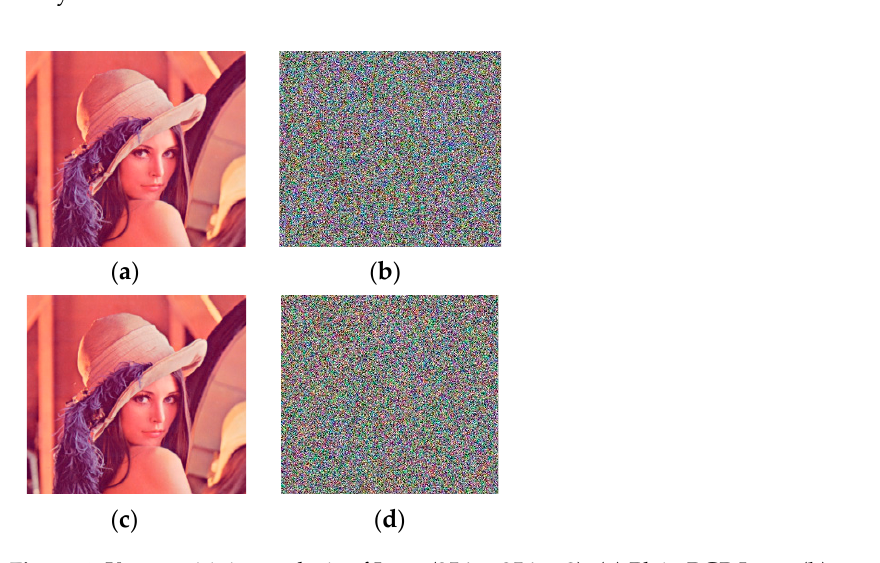
Figure 4. Key sensitivity analysis of Lena (256 × 256 × 3). ( a ) Plain RGB Lena; ( b ) encrypted Lena using a set of keys; ( c ) decrypted Lena using a correct set of keys; ( d ) decrypted Lena by bringing a minor change in one of the keys.